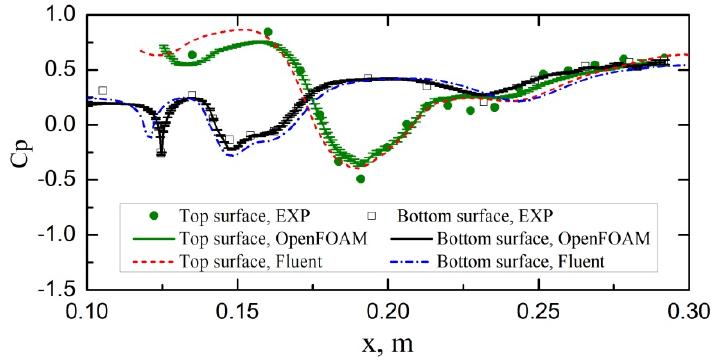
Figure 7. Comparison of the surface static pressure results between the experiment and both CFD methods at M = 0.7 and p AIP / p 0 = 1.18 in the absence of gust.